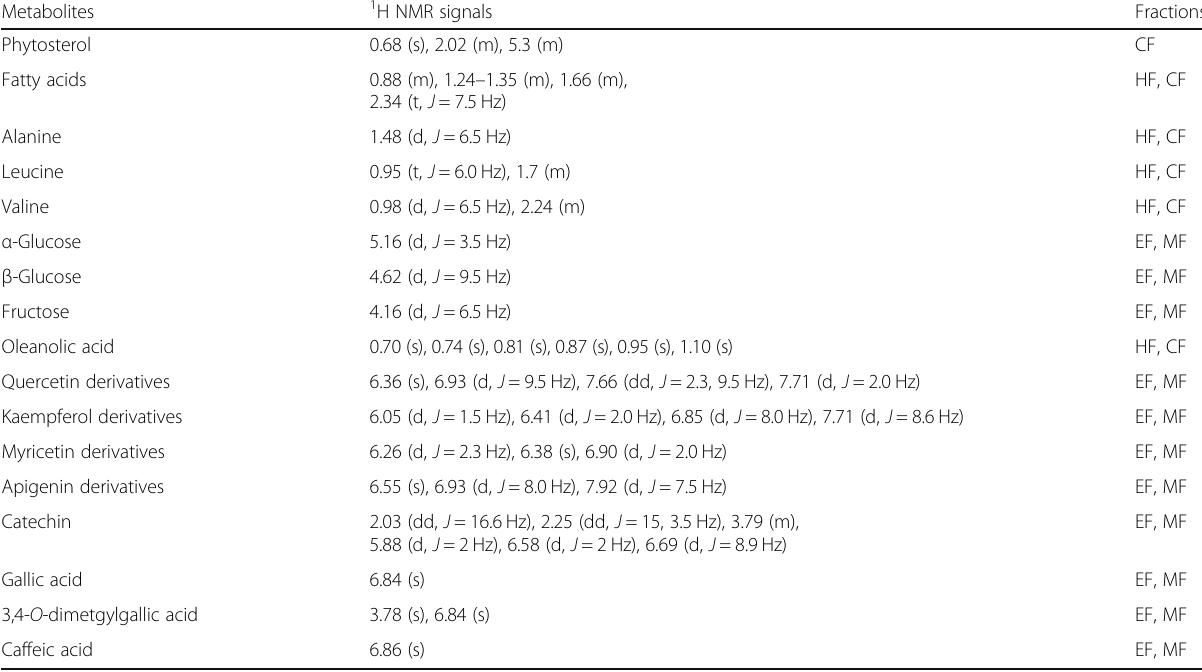
Table 1 1 H NMR signals of identified metabolites in N. oleracea fractions Metabolites 1 H NMR signals Fractions Phytosterol 0.68 (s), 2.02 (m), 5.3